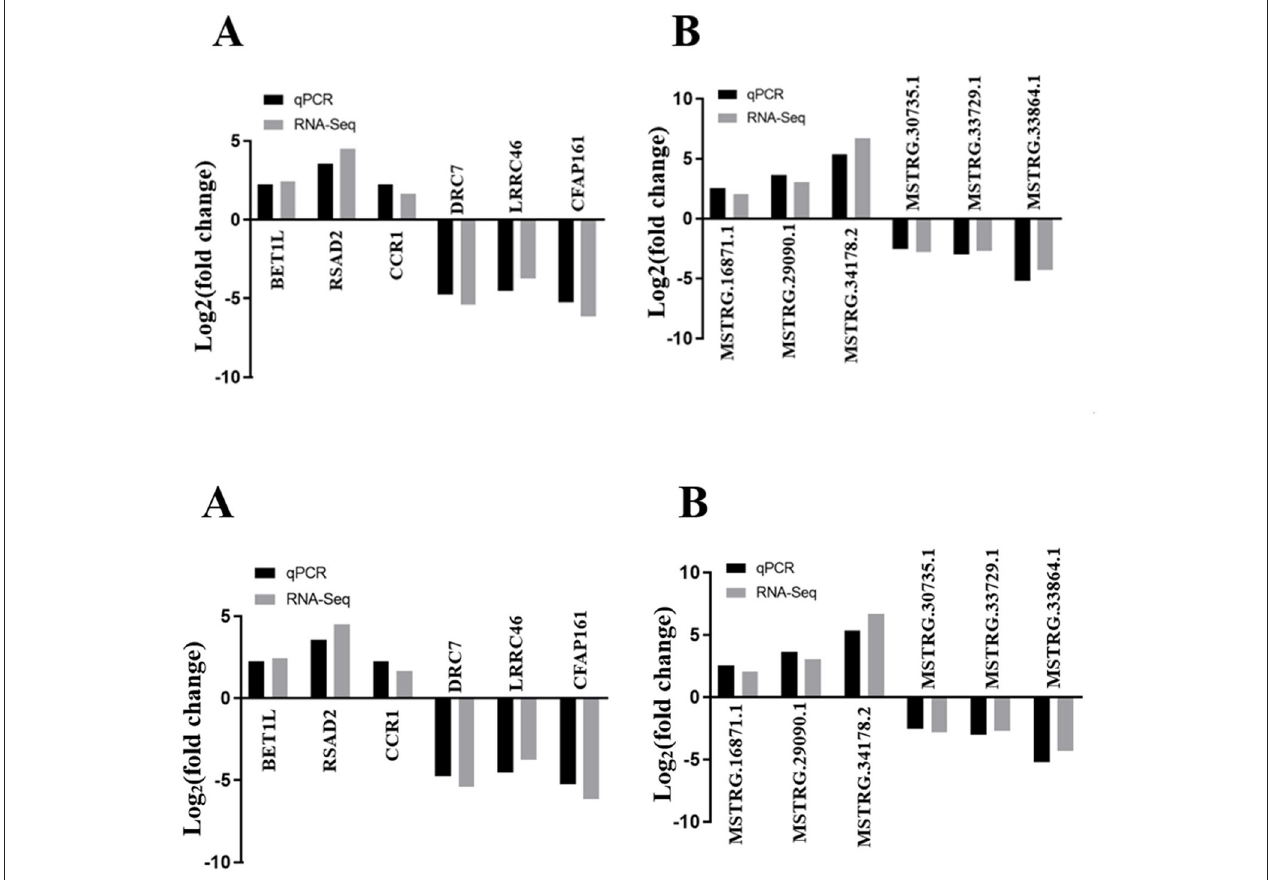
FIGURE 7 | The validation of RNA-seq by qRT-PCR ( n = 5). (A) qRT-PCR validation of six mRNAs. (B) qRT-PCR validation of six